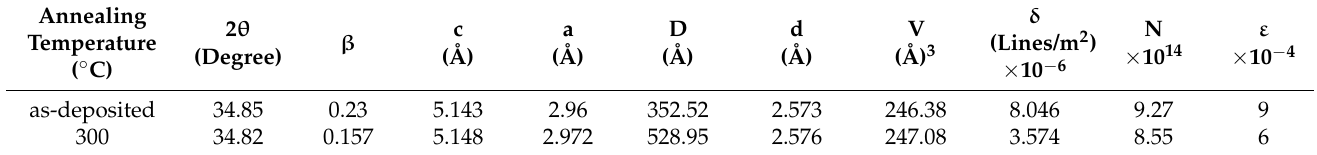
Table 2. X-ray analysis of hexagonal ZnS with a peak intensity of (103)